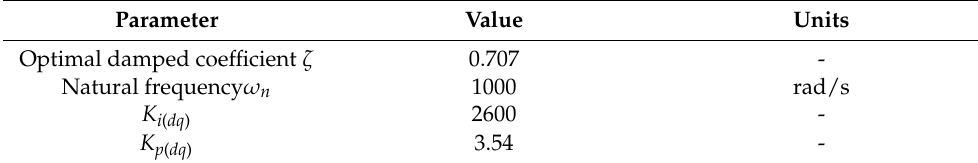
Table A2. PI-Controller Parameters of the 6P-AFPMSM.